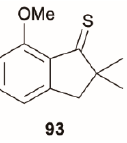
Figure 22. Absorption (gray filled area) and emission spectra (blue filled area and solid red line) of 93 in cyclohexane at room temperature. Insets: expansions of the absorption spectra over specified